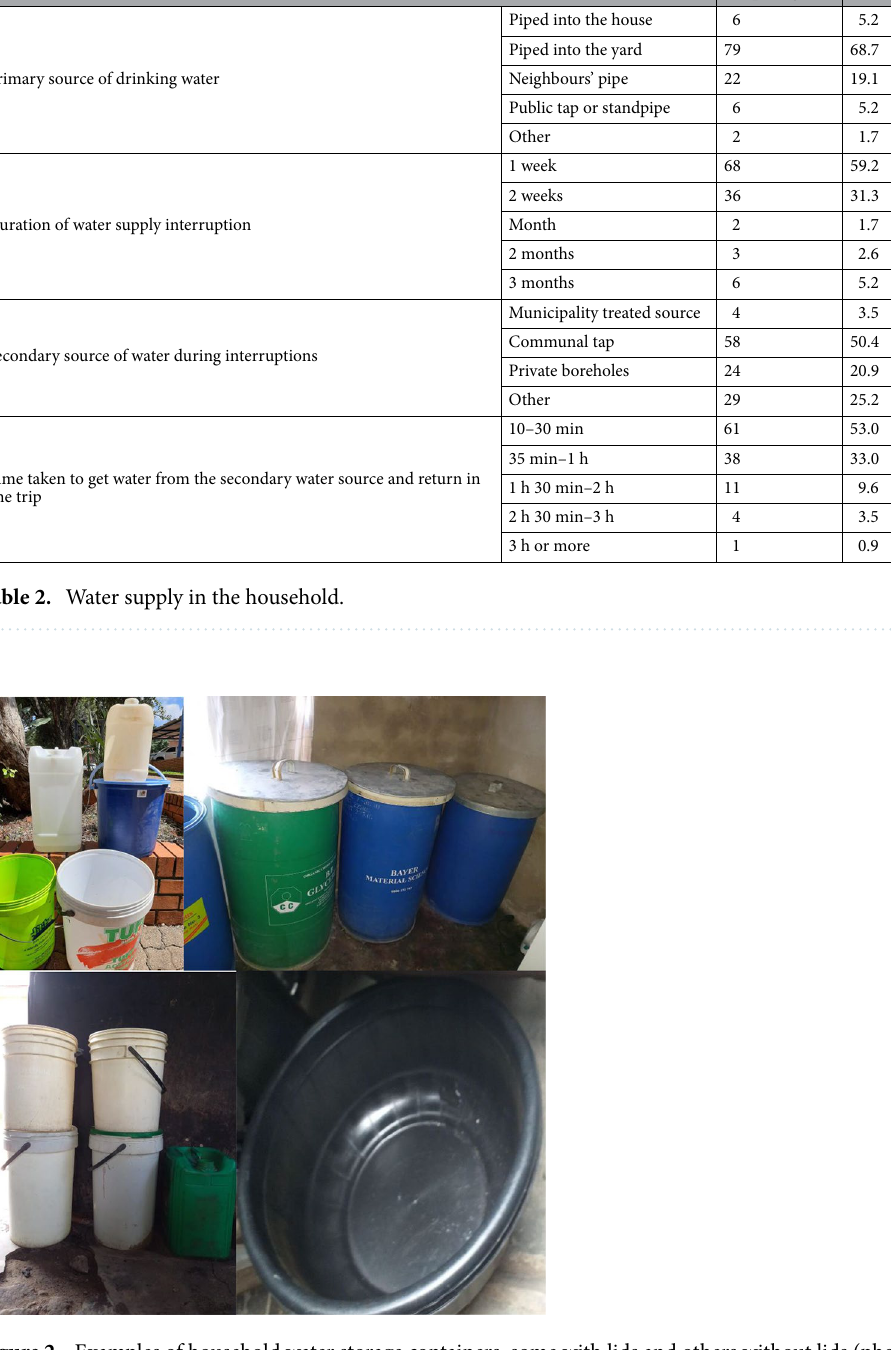
Figure 2. Examples of household water storage containers, some with lids and others without lids (photo from